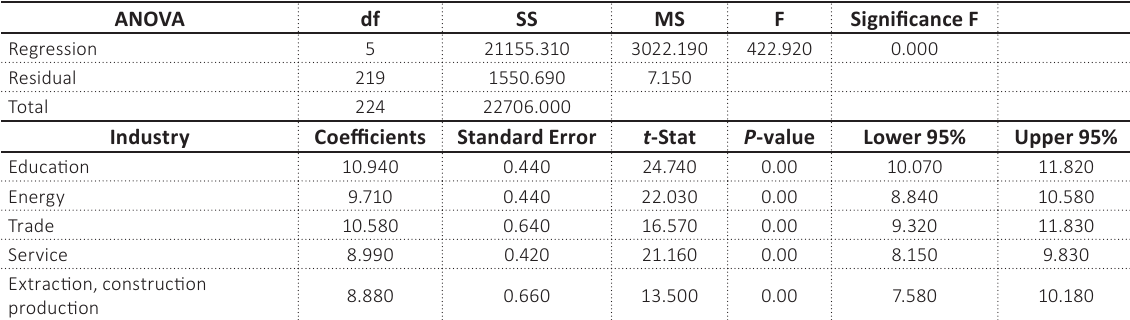
Table 4. Dispersion analysis of the equation (4) parameters